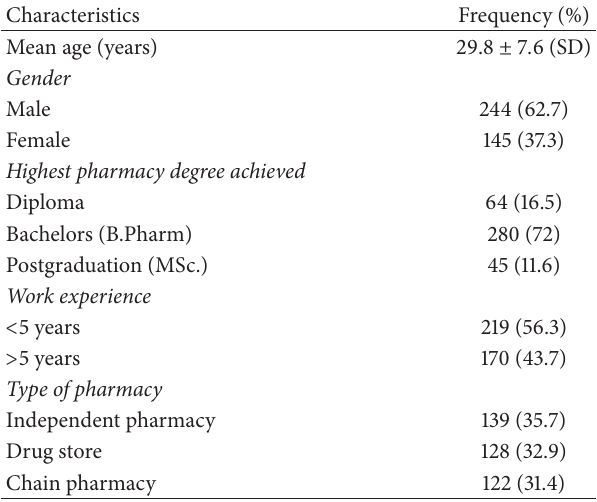
Table 1: Demographic characteristics of community pharmacists in Ethiopia ( 𝑁 = 389